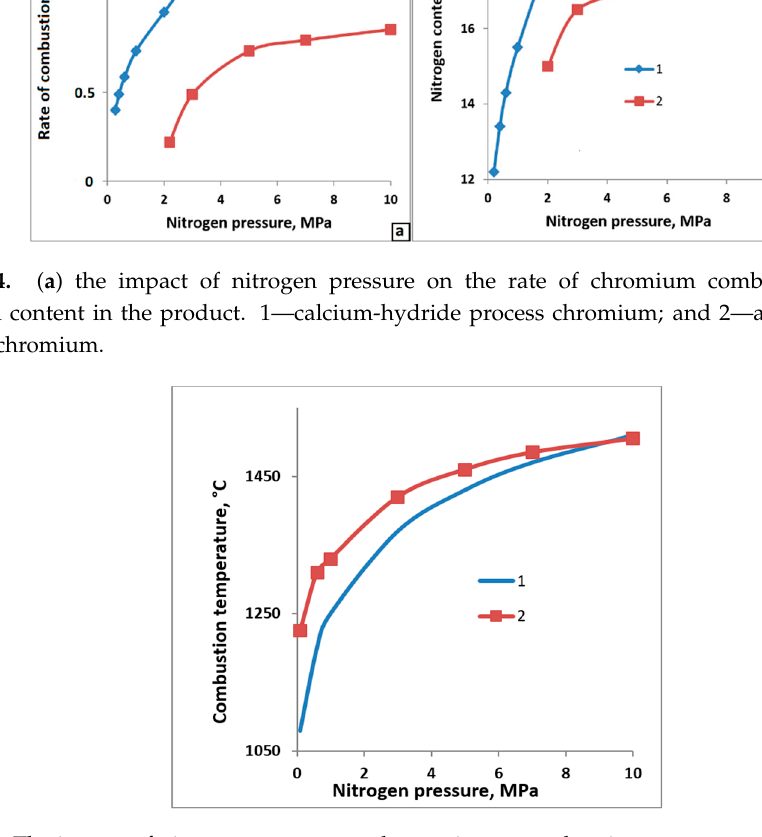
Figure 5. The impact of nitrogen pressure on the maximum combustion temperature; 1 — estimated and 2 — measured.